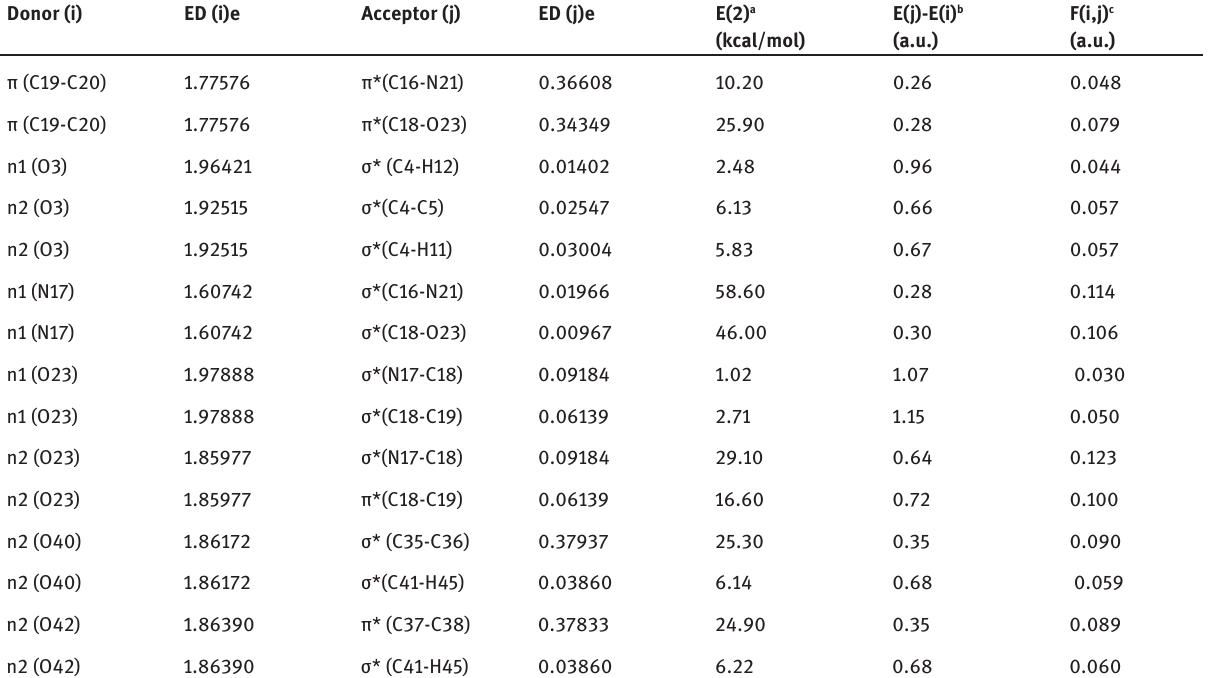
Table 2: The most important interactions between ‘filled’ (donors) Lewis-type NBOs and ‘empty’ (acceptors) non-Lewis NBOs of the title